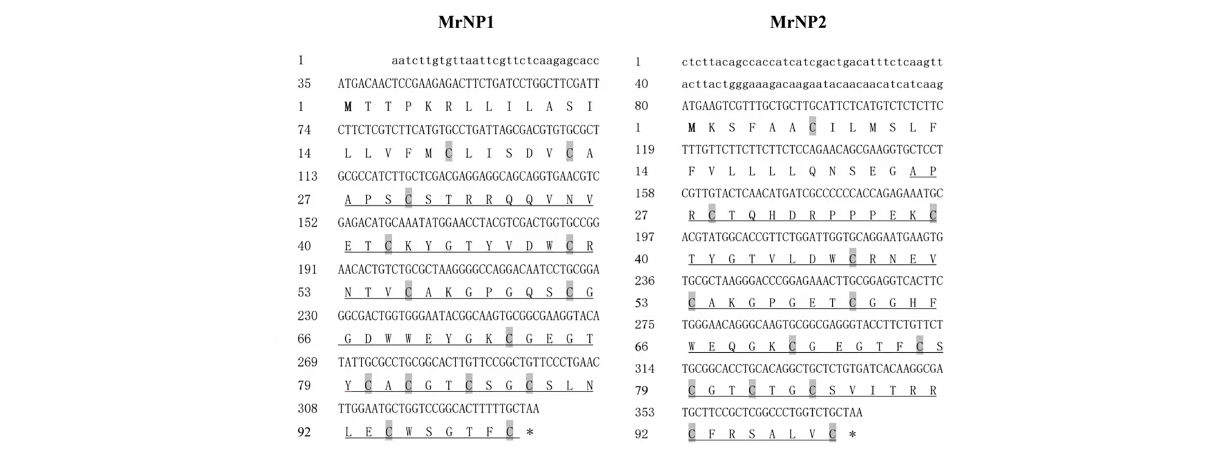
FIGURE 1 | Deduced amino acid of the partial cDNAs of MrNP1 (left) and MrNP2 (right). One letter amino acid code is shown. The two partial cDNAs consist of all the coding/translation information. Underlined parts represent mature peptide.